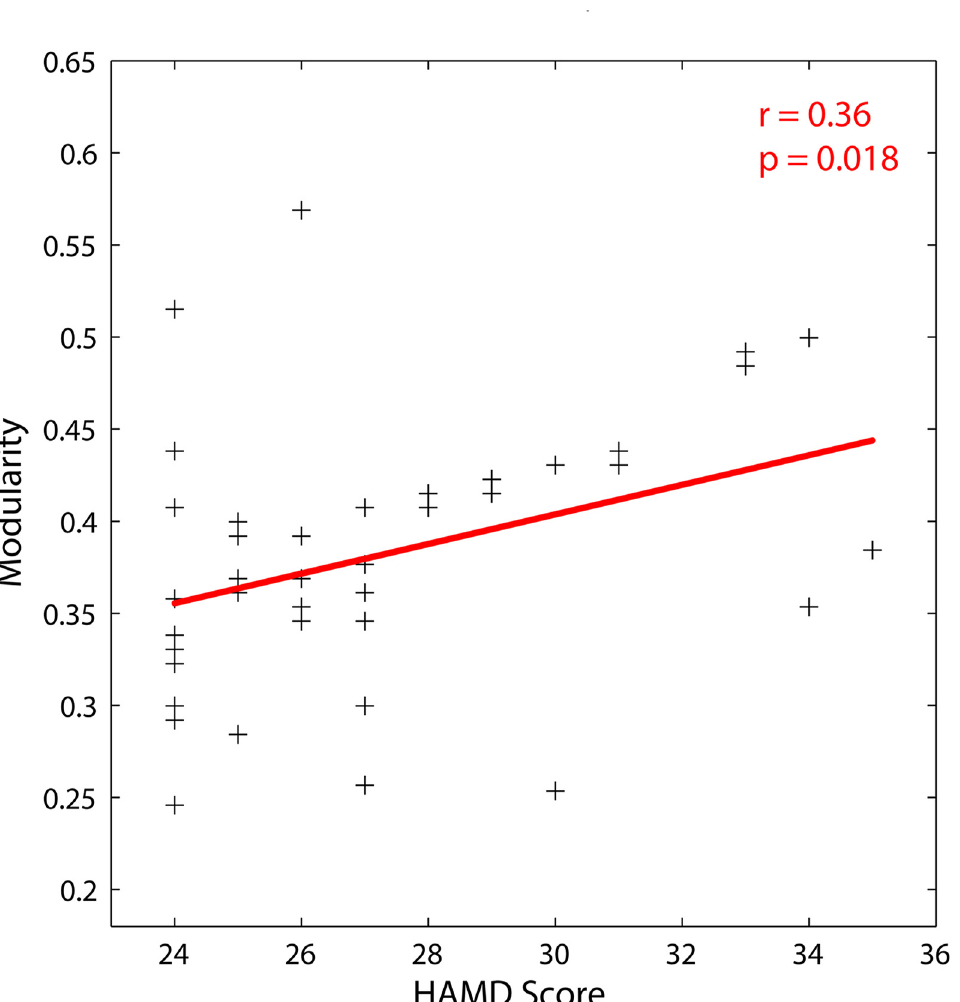
Fig 5. Scatter plot with trend line showed the relationship between modularity and HAMD scores for cost = 0.21 in MDD patients.